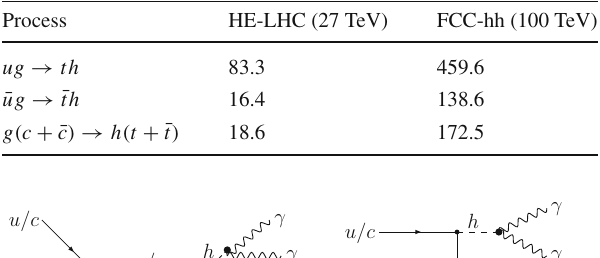
Table 1 The cross sections (in fb) of the subprocess pp → th with = 0 . 01 at HE-LHC and FCC-hh κ tqh Process